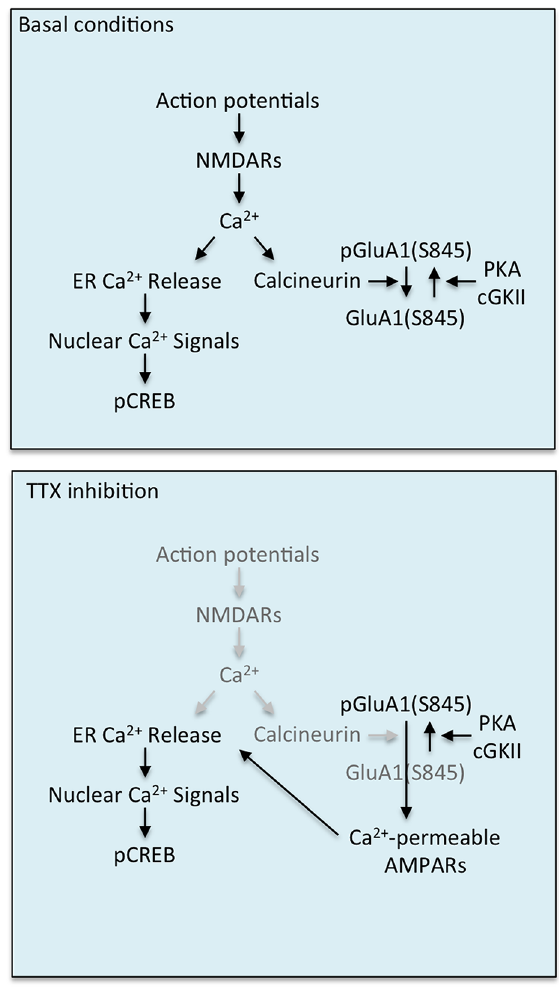
Figure 10. A model of CPAR/calcineurin-dependent synaptic scaling for homeostasis of Ca 2 + signaling. A model showing regulation of synaptic insertion of CPAR by calcineurin leading to activity deprivation-induced synaptic scaling, followed by homeostasis of CREB activation in cultured cortical neurons.